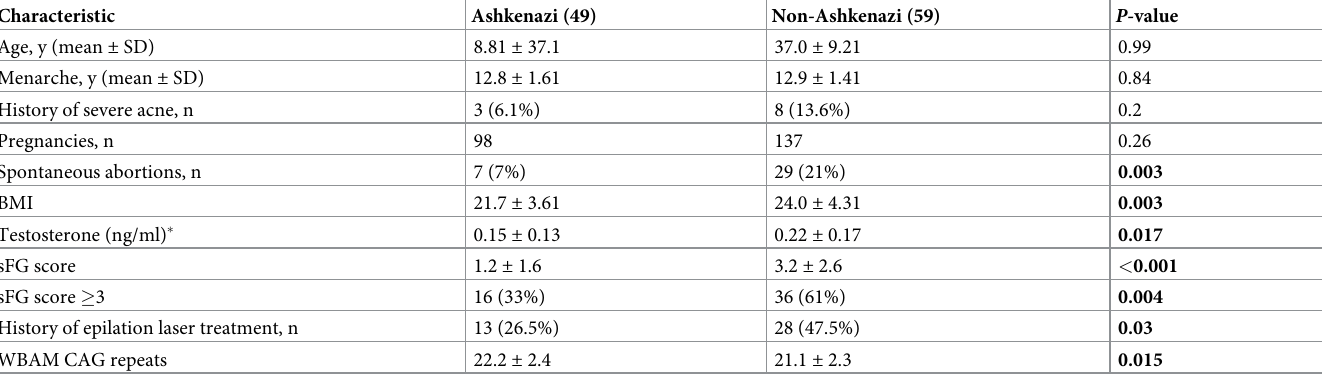
SD, Standard deviation; BMI, Body max index; ng/dL, Nanogram/deciliter; sFG, Simplified Ferriman-Gallwey score; WBAM, Weighted mean of the bi-allelic measurement. The values in bold are significant.